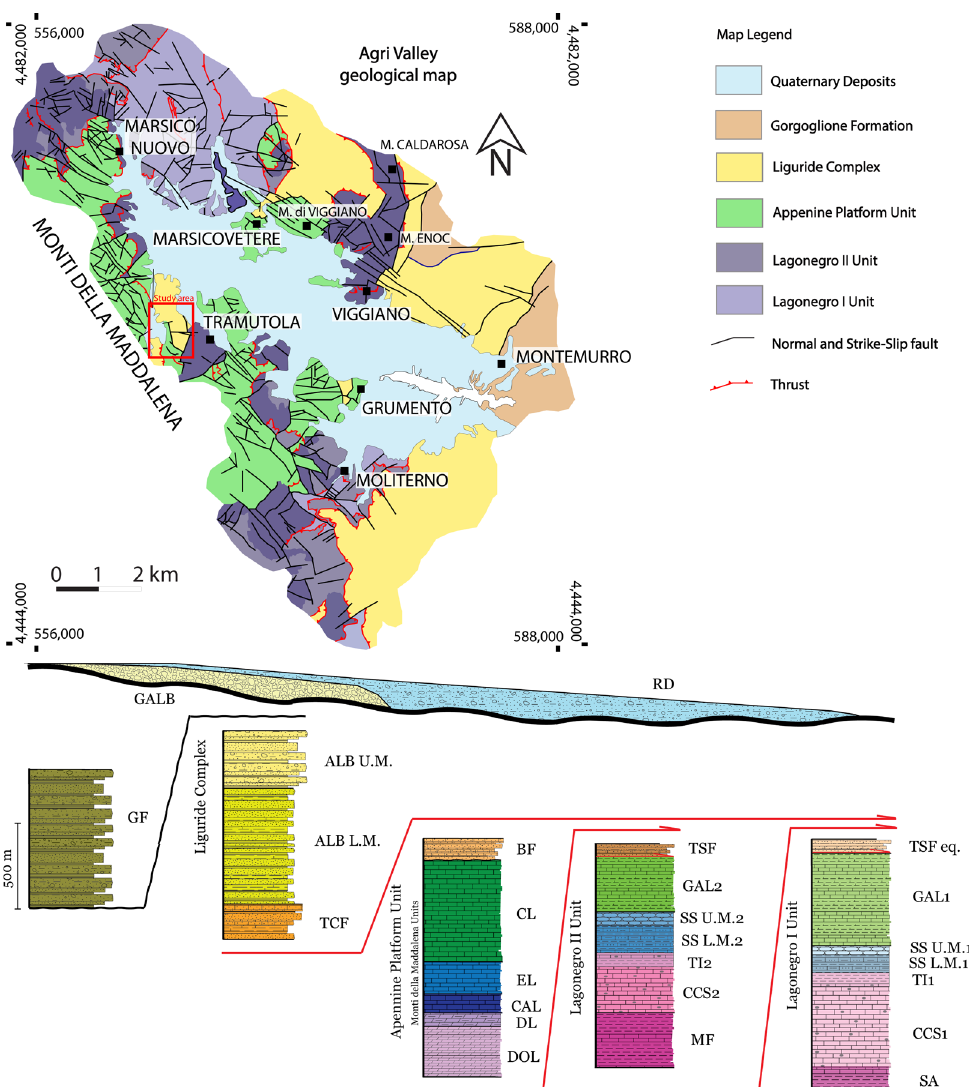
Figure 2. Geological–structural map of the Agri Valley modified from published geological maps [78–82]; the red box identifies the study area. Stratigraphic–structural scheme of the tectonic units exposed in the Agri Valley. Recent deposit (RD), Galaino breccia (GALB), Gorgoglione Formation (GF), Albidona Formation upper member (ALB U.M.), Albidona Formation lower member (ALB L.M.), Torrente Cavolo Formation (TCF), Bifurto Formation (BF), crystalline limestone (CL), Ellipsactinia limestone (EL), calcirudite (CAL), dolomitic limestone (DL); for Lagonegro II Unit: Torrente Serrapotamo Formation (TSF), Galestri Formation (GAL2), Scisti Silicei upper member (SS U.M.2), Scisti Silicei lower member (SS L.M.2), transitional interval (TI2), Calcari Son Selce Formation (CCS2), Monte Facito Formation (MF); for Lagonegro II Unit: Torrente Serrapotamo equivalent Formation (TSF eq.), Galestri Formation (GAL1), Scisti Silicei upper member (SS U.M.1), Scisti Silicei lower member (SS L.M.1), transitional interval (TI1), Calcari Son Selce Formation (CCS1), Sorgente Acero Formation (SA).